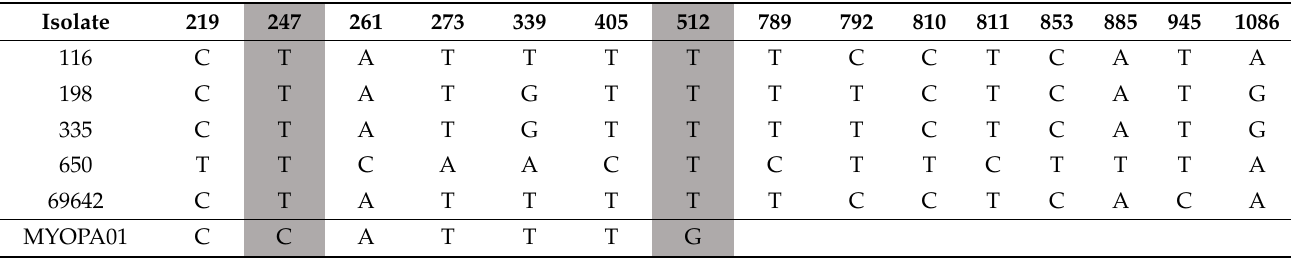
Table 1. Nucleic acid polymorphism in mitochondrial cytochrome b gene ( cytb ) sequences of Polychromophilus sp. isolates from Brazil (116, 198, 335, 650, and 69642) and Panama (MYOPA01). Isolate 219 247 261 273 339